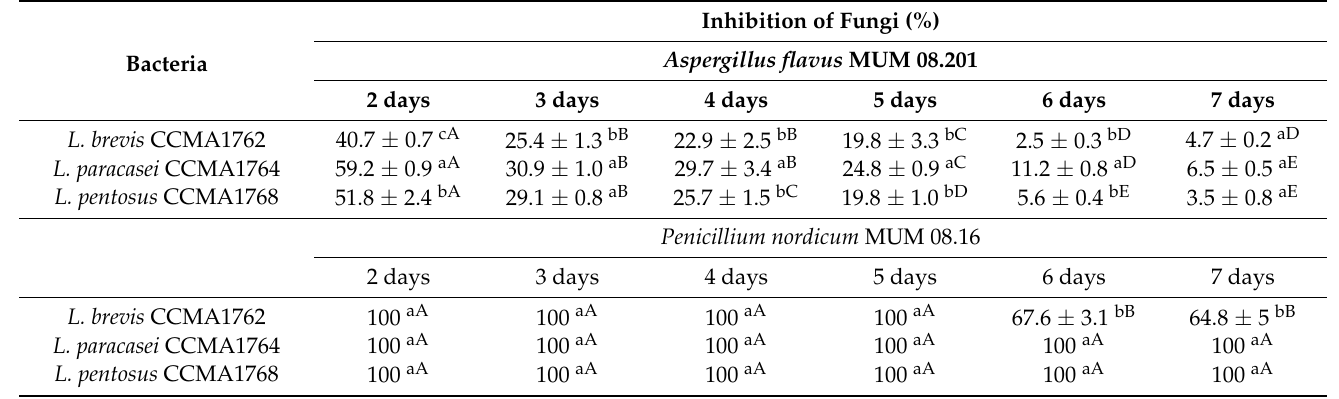
Table 5. Antifungal activity of LAB